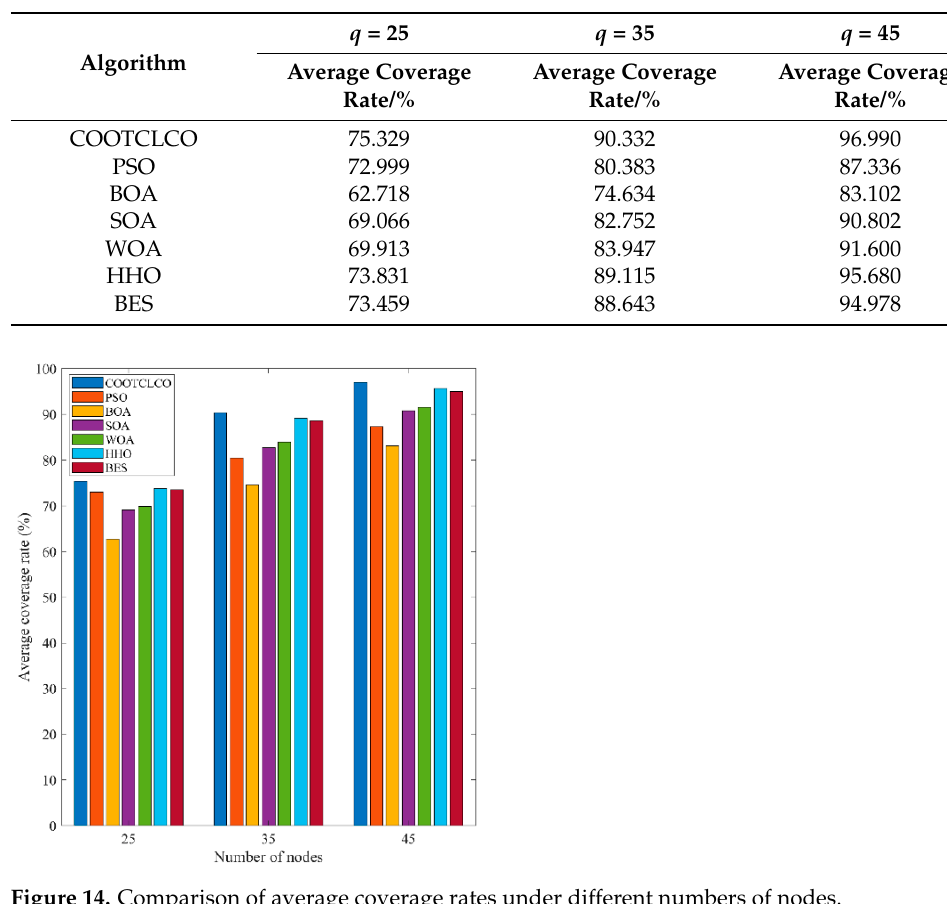
Table 10. Comparison of average coverage rate.